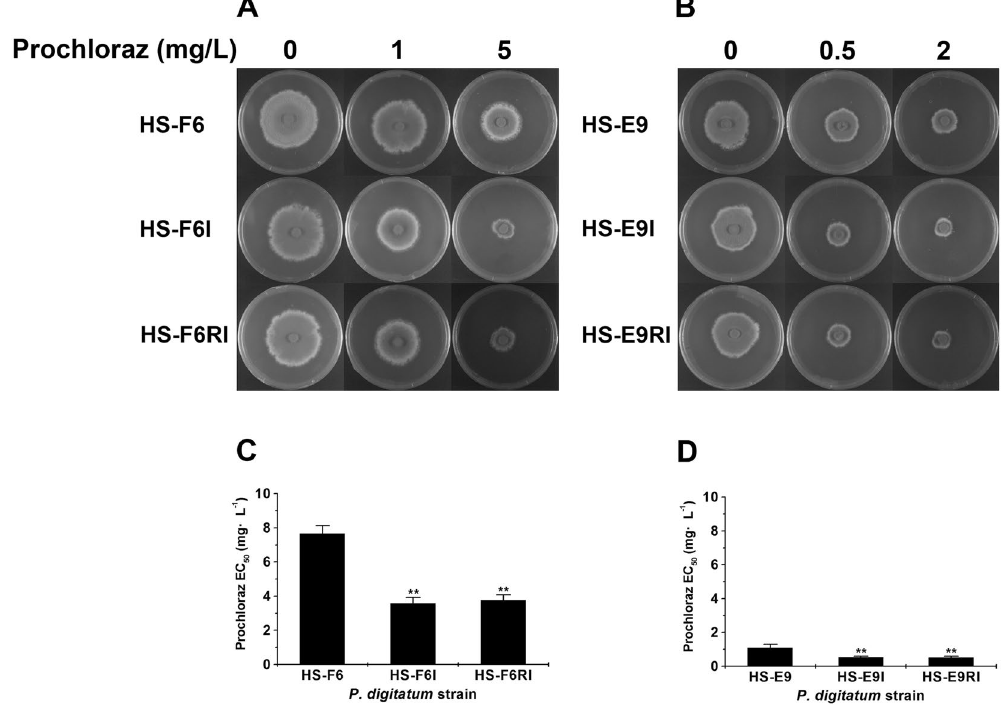
Figure 4. Comparison of prochloraz resistance of P. digitatum strains (HS-F6 and HS-E9) with or without coinfection by PdPmV1 and PdNLV1. ( A ) Growth assay of P. digitatum strains HS-F6 (virus-free), HS-F6I (coinfected by PdPmV1 and PdNLV1 from HS-RH2), and HS-F6RI (coinfected by PdPmV1 and PdNLV1 from HS-F6I) on PDA plates with or without prochloraz (concentrations: 0, 1 and 5 mg·L − 1 ). ( B ) Growth assay of P. digitatum strains HS-E9 (virus-free), HS-E9I (coinfected by PdPmV1 and PdNLV1 from HS-RH2), and HS-E9RI (coinfected by PdPmV1 and PdNLV1 from HS-E9I) on PDA plates with or without prochloraz (concentrations: 0, 0.5 and 2 mg·L − 1 ). All the strains were cultured at 25 °C for four days. ( C ) Comparison of prochloraz EC 50 values of the P. digitatum strains HS-F6, HS-F6I and HS-F6RI. Each bar represents the EC 50 value plus standard error of three measurements ( ** P < 0.01). ( D ) Comparison of prochloraz EC 50 values of the P. digitatum strains HS-E9, HS-E9I and HS-E9RI. Each bar represents the EC 50 value plus standard error of three measurements ( ** P <